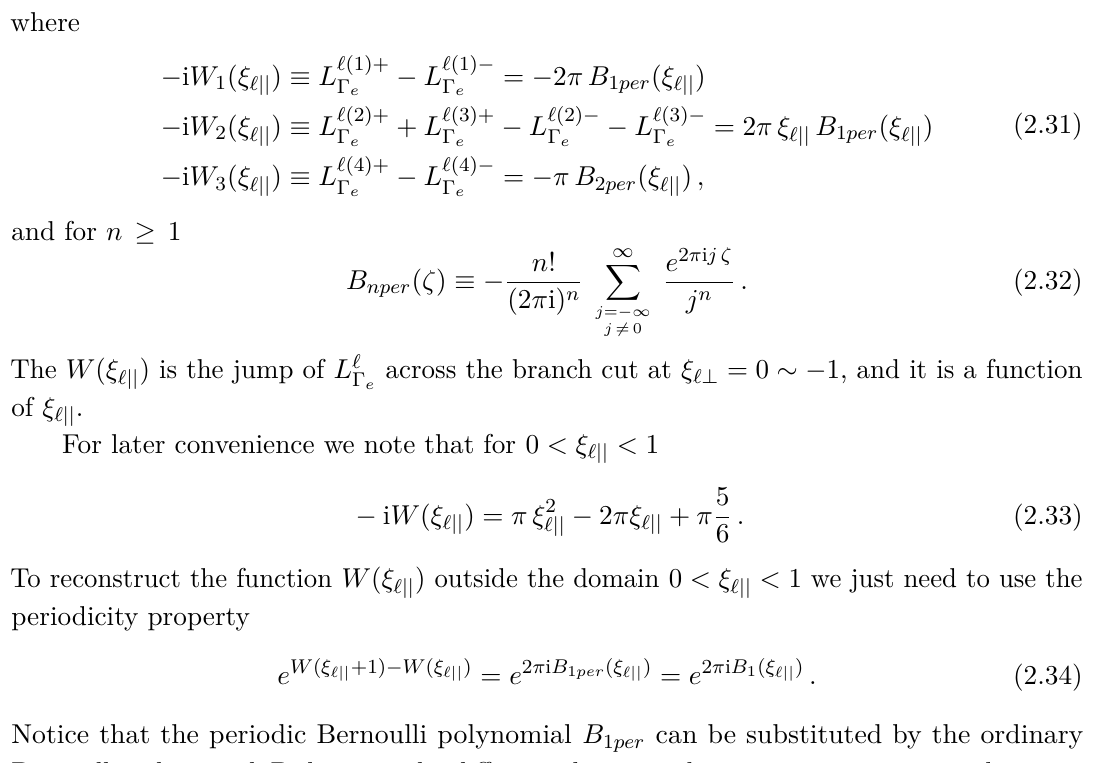
Figure 5 . The blue points represent log Γ e ( ξ ⊥ + 0 . 2 τ, τ, τ ) for − 0 . 1 < ξ ⊥ < 0 . 1 and τ = i − 1 have used a truncation of (2.9) at j = 1000 . The red points represent the piece-wise polynomial part πi B 3 , 3 ( ξ ⊥ −b ξ ⊥ c +0 . 2 τ | τ, τ, − 1) . The branch cut of the piece-wise polynomial part is 3